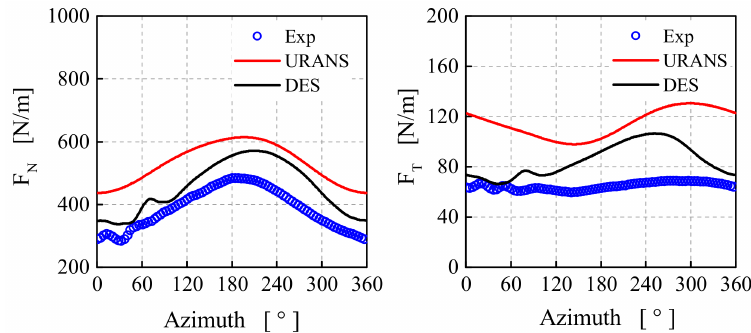
Figure 16. Normal and tangential forces variations at 60% span at 24 m/s wind inflow.